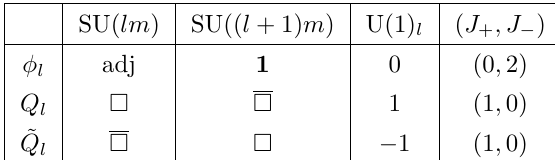
are baryonic flavor symmetries l